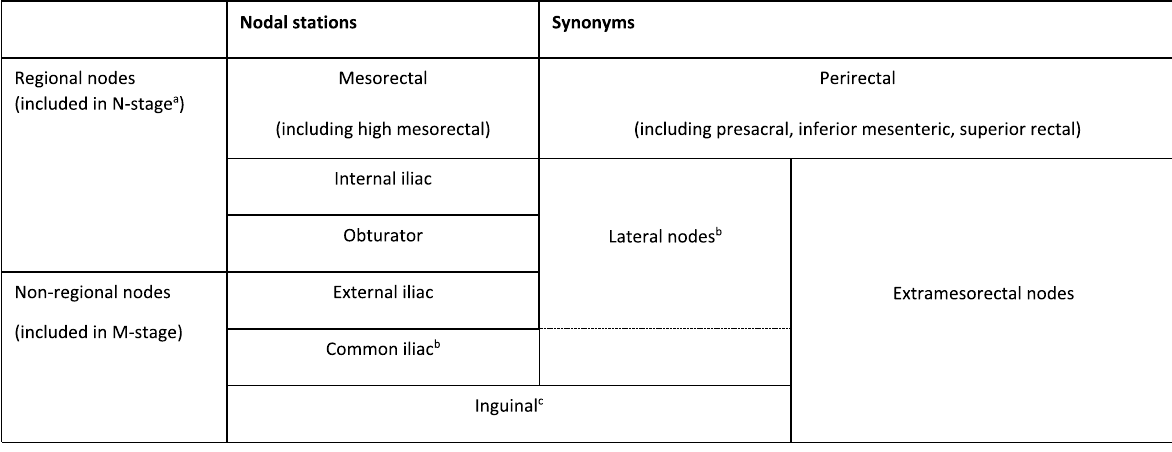
Table 3 Terminology to describe regional and non‑regional pelvic lymph nodes for rectal cancer